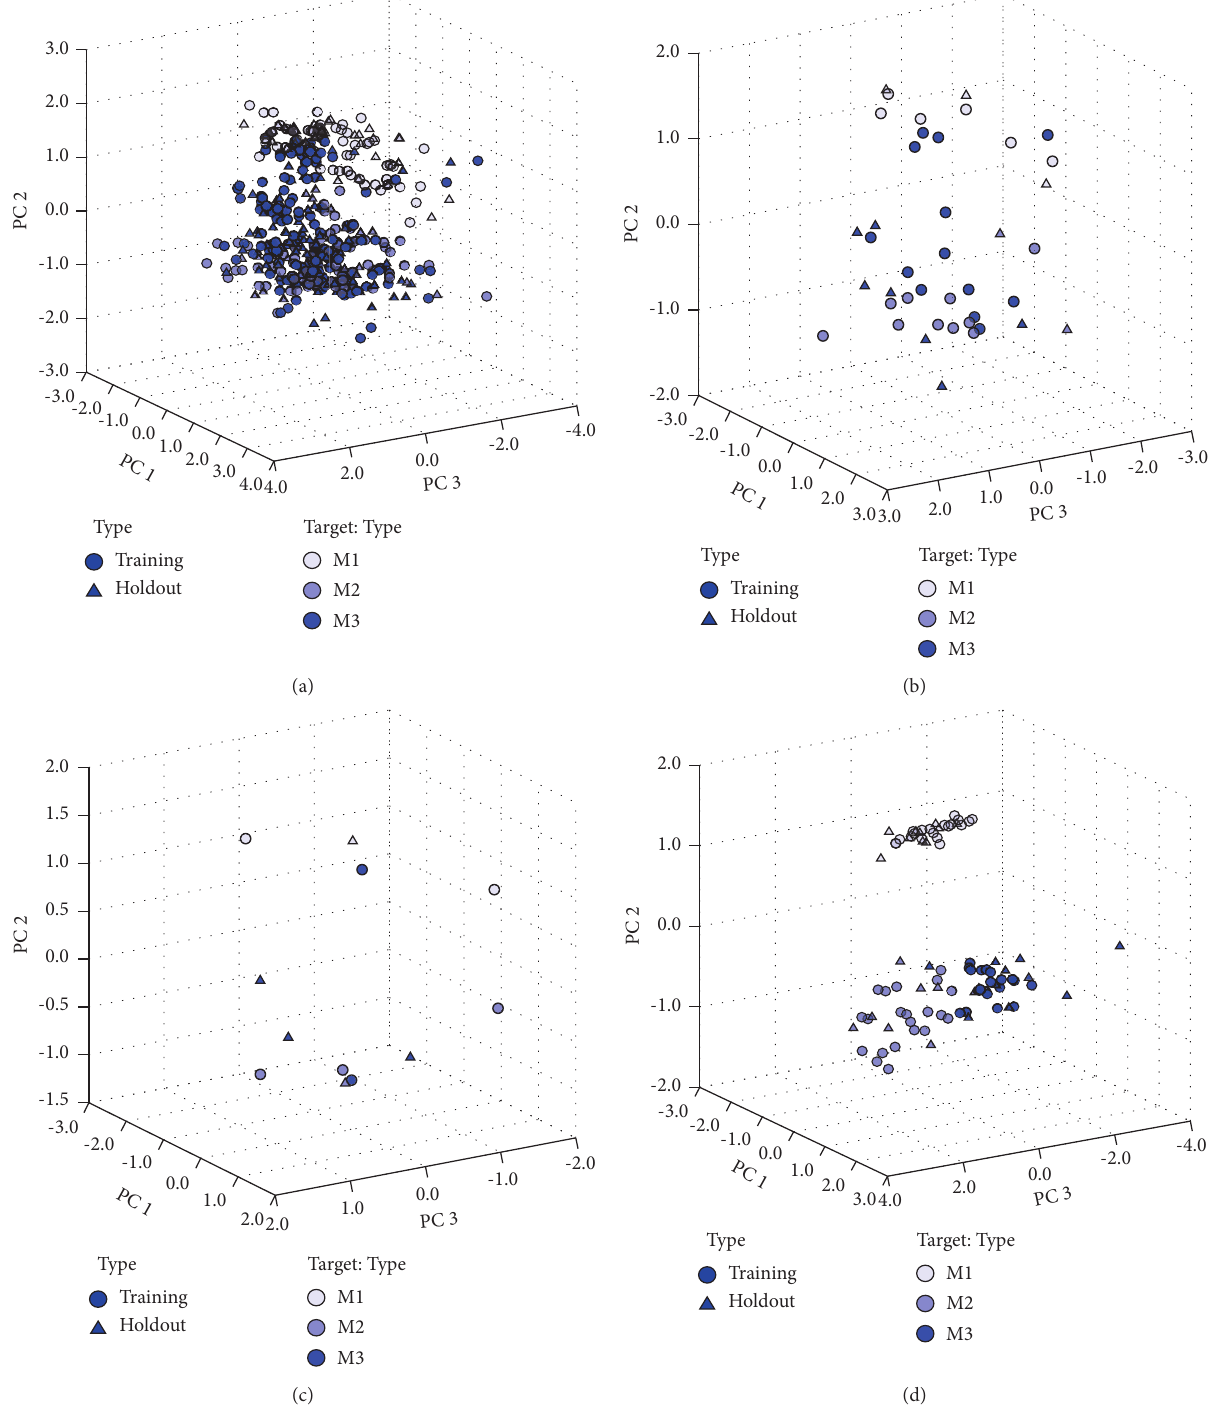
Figure 7: (a–d) kNN results for levels: L0 using k � 5 (a), L1 using k � 4 (b), L2 using k � 1 (c), and L0x using k � 3 (d), on a PCA